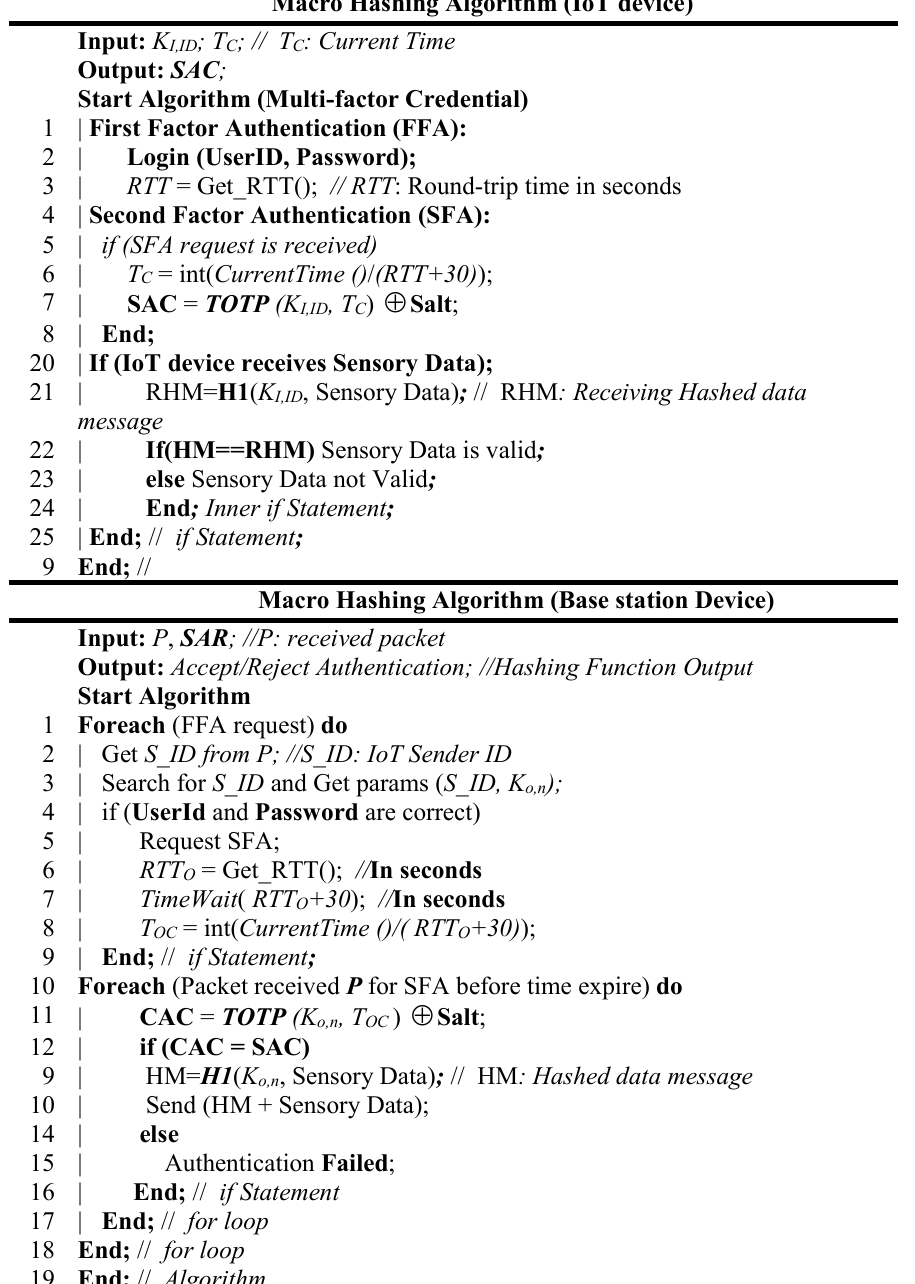
Figure 3. Cont. Figure 3.